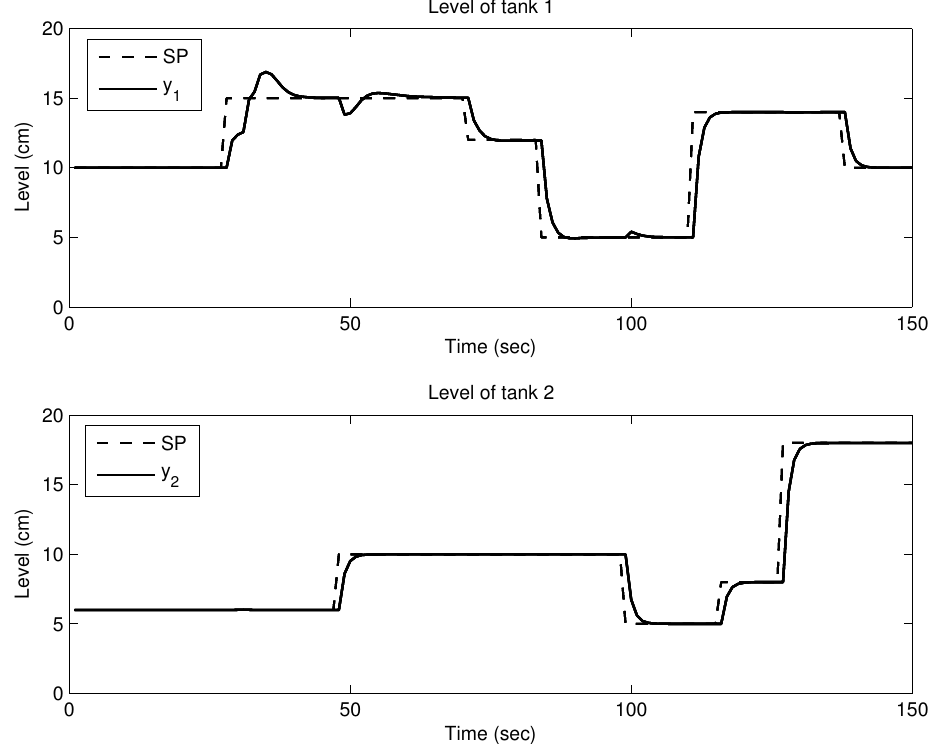
Figure 7. MIMO-APC performance in minimum phase